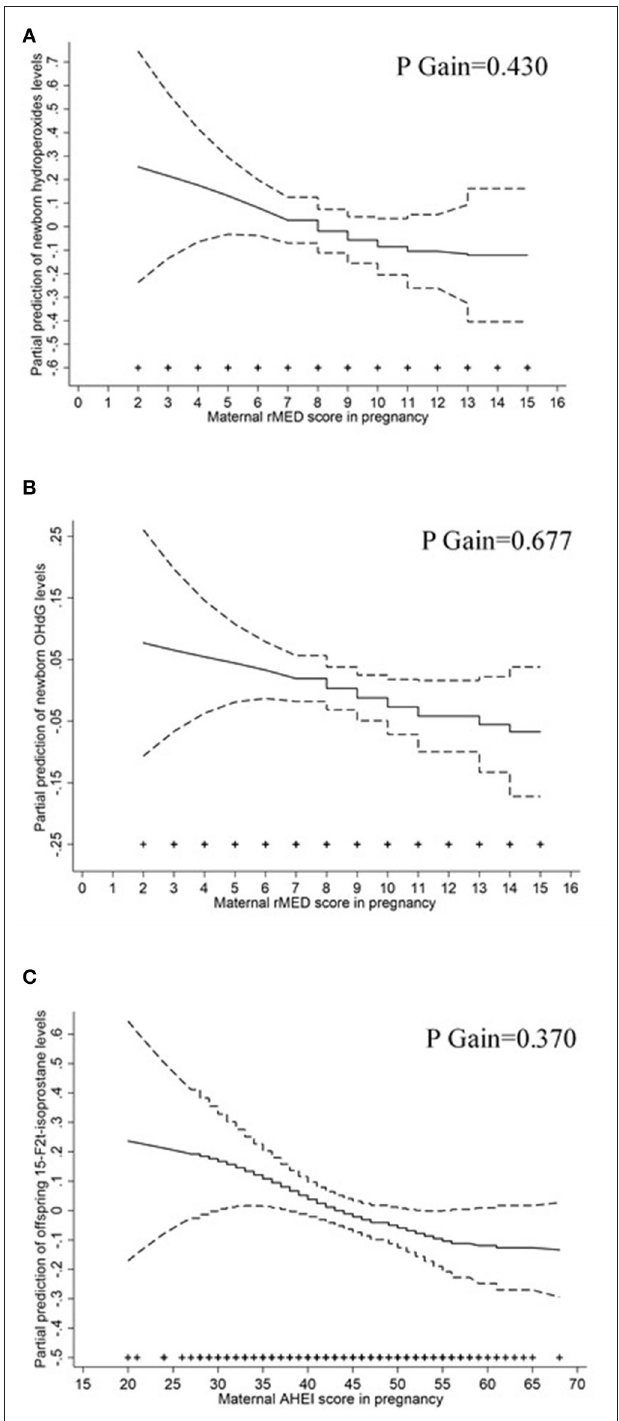
FIGURE 2 | The relation (and 95% CI s) of maternal dietary scores in pregnancy with the concentrations of selected offspring biomarkers of oxidative stress. General additive models adjusted for maternal social class, maternal smoking during pregnancy, and total intake of calories for (A) maternal rMED score and circulating levels of hydroperoxides in newborns; and (B) maternal rMED score and circulating levels of 8OHdG in newborns; and (C) maternal Alternate Healthy Index (AHEI) score and offspring urinary 15F-2t-isoprostane levels. The symbols ( + ) on the X -axis indicate maternal dietary score